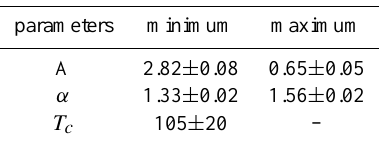
Table 2. Parameters of the fit: maximum and minimum compari- son. T c is expressed in